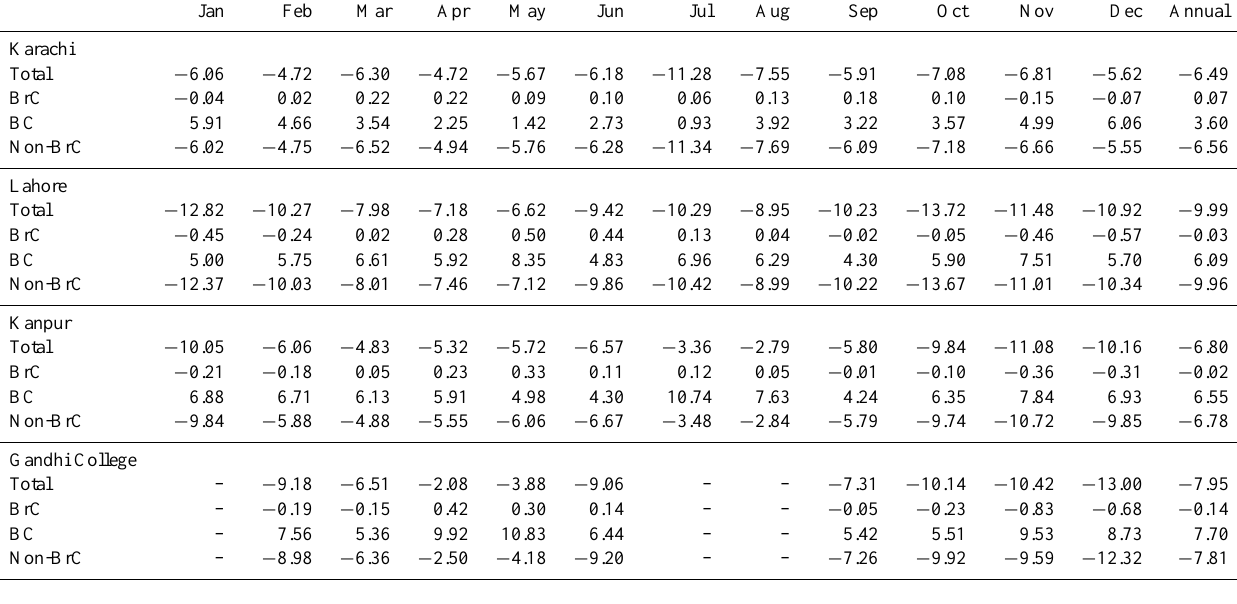
Table 3. Monthly DRE (Wm − 2 ) of different aerosol types, “non-BrC” referring to the case with all aerosols other than BrC. The annual mean is shown after December. The three missing months of Gandhi College had fewer than 10 observations.